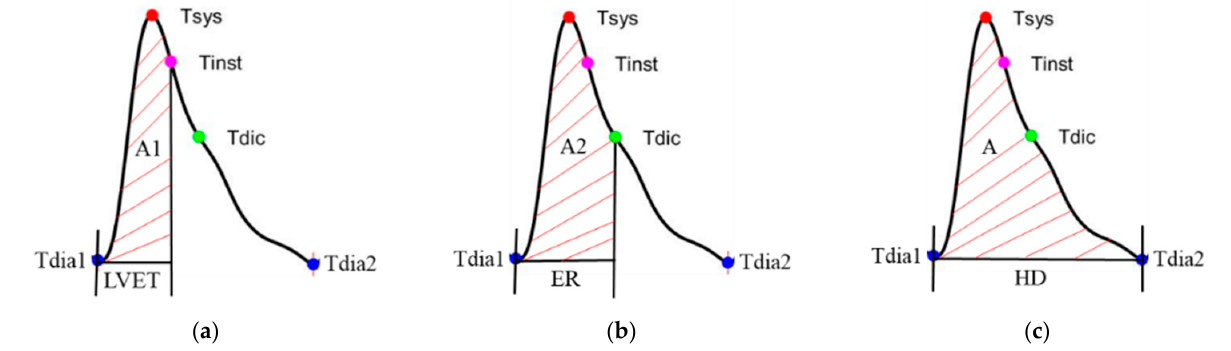
Figure 8. ( a ) The left ventricular ejection time (LVET) is defined at the systolic ending time (Tinst), the integral area of which is A1, ( b ) the ejection relaxation time (ER) is defined at the dicrotic notch time (Tdic), the integral area of which is A2, and ( c ) the total area is defined as A. Table 1. The ten extended parameters including four different ratios, time to time, time to area, area to time, and area to area.